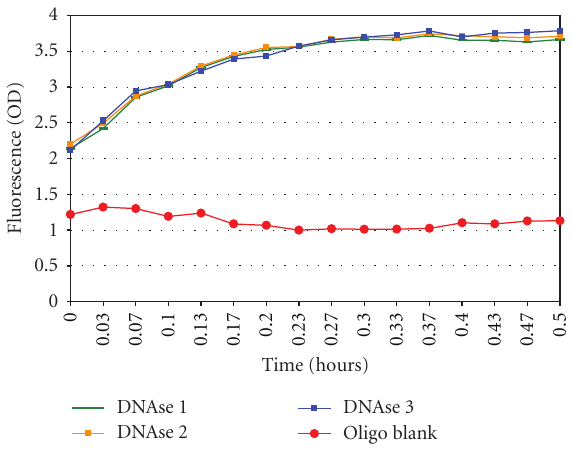
Figure 5: Continuous measurement of oligo 18-mer hydrolysis by DNAse I by fluorescence assay. ∗ Analysis of DNAse I positive con- trol via continuous, fluorescence-based assay on Fluoroskan II (Fin- struments) demonstrates that 5 (cid:3) -6-FAM-ATATAGCGC 5 T 5 -DQ1-3 (cid:3) 18-mer hydrolysis probe is cleaved by DNAse I and that adequate quenching to allow di ff erentiation between cut and uncut probe was achieved. Oligo blank contained all reaction components except for DNAse I (25mM Tris-HCl, 50mM NaCl, 10mM MgCl 2 , pH 7.5, and 1 μ g/mL 5 (cid:3) -6-FAM-ATATAGCGC 5 T 5 -DQ1-3 (cid:3) 18-mer hydroly- sis probe). Results were consistent across all trials. DNAse I trials 1, 2, and 3 are displayed as representative trials. Pooled fluorescence data showed statistical significant di ff erence from oligo blank ( F = 29.78, P < 0 . 0001).